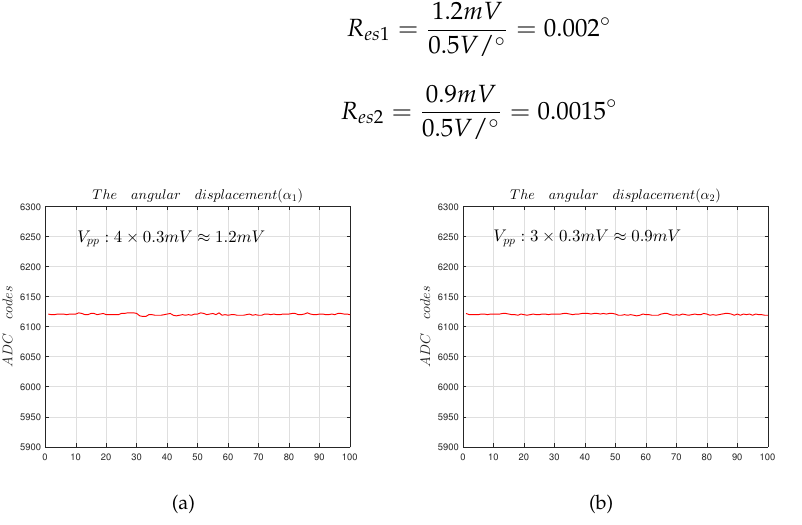
Figure 24. The sensor resolution test: ( a ) angular displacement α 1 noise calculation; ( b ) angular displacement α 2 noise